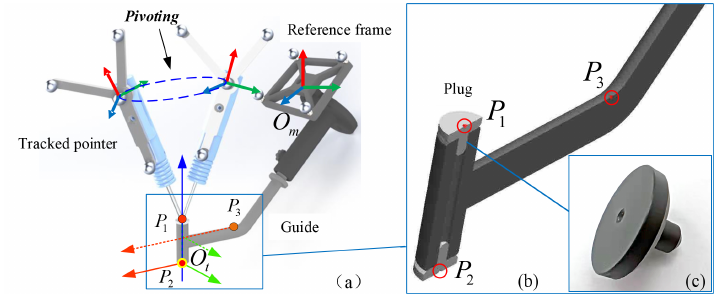
Figure 6. TCP Calibration by using a tracked pointer. ( a ) positions of points P 1 , P 2 and P 3 are obtained by pivoting, which are used to build the local COS O t of the guiding tube. Specifically, the origin of he local COS O t is located at P 2 . ( b ) Two points P 1 and P 2 are at the center of plugs inserting into the guiding tube, and the third point P 3 is on the guide. ( c ) A plug is designed for digitizing the end point of the guiding